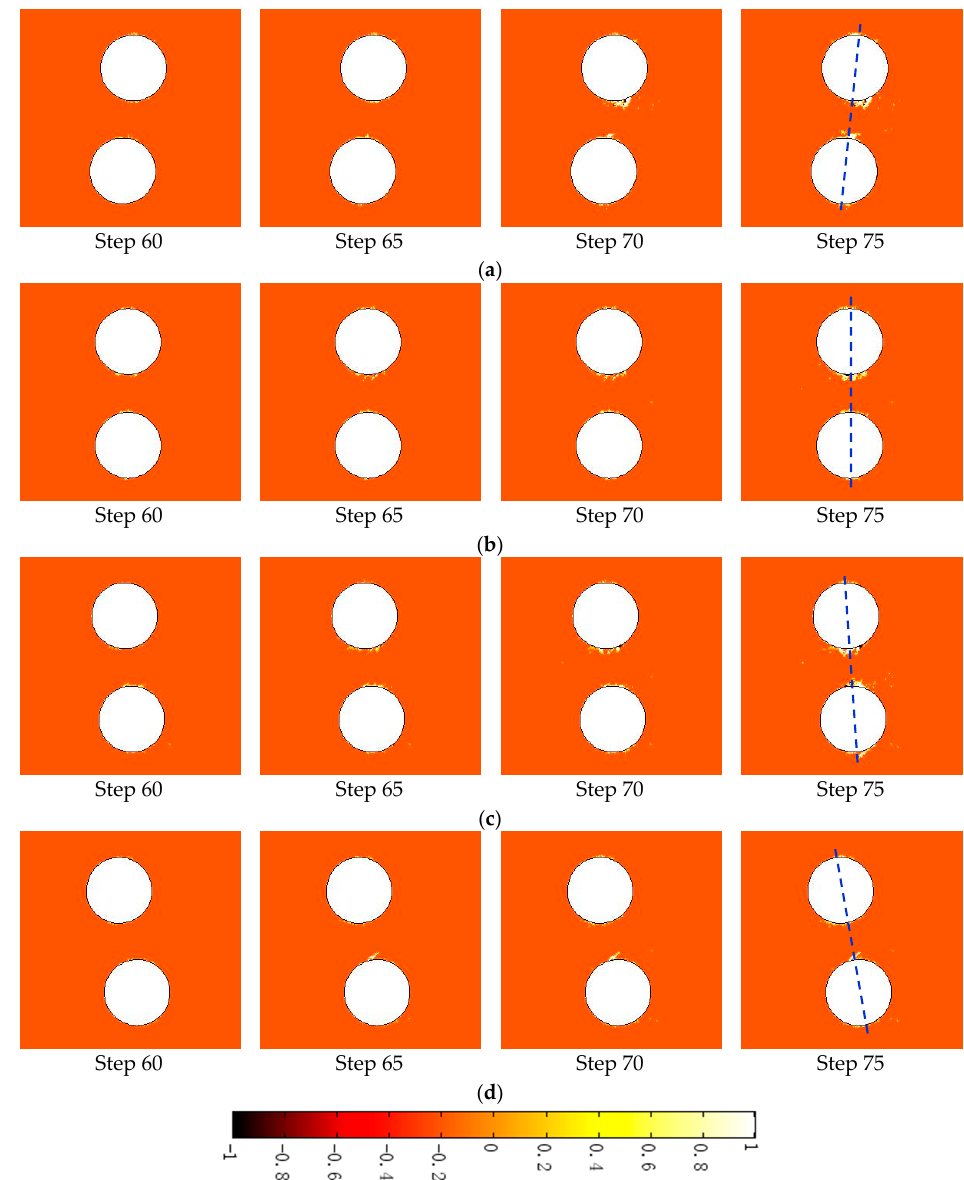
Figure 9. Damage zone evolution under different in situ stress conditions at the excavation stage: ( a ) σ trend of 310 ◦ , β = − 6 ◦ ; ( b ) σ 1 trend of 316 ◦ , β = 0 ◦ ; ( c ) σ 1 trend of 320 ◦ , β = 4 ◦ ; ( d ) σ 1 trend of 326 ◦ , β = 10 ◦ .